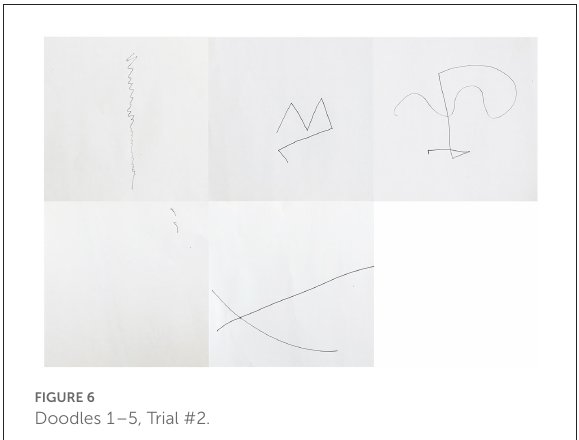
FIGURE6 Doodles 1–5, Trial